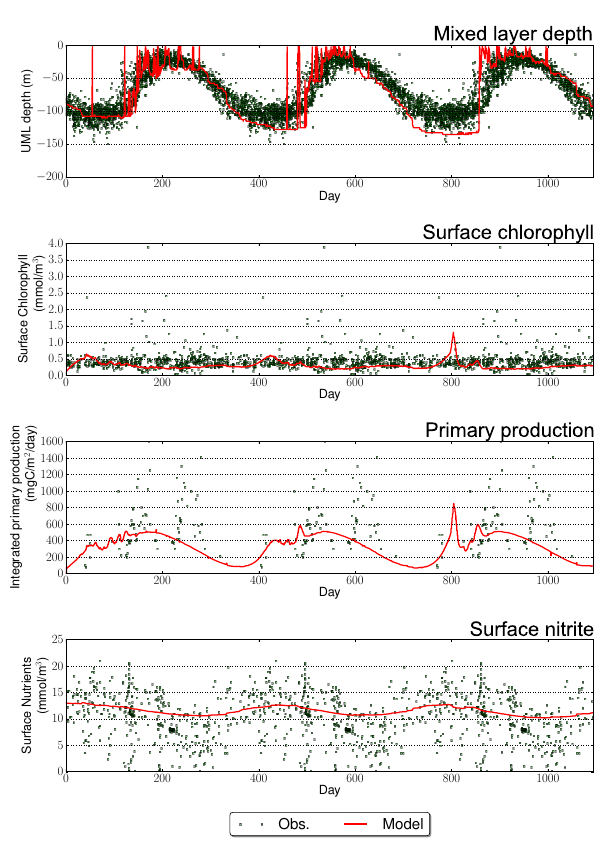
Fig. 2. Summary of simulated physical and biological behaviour at Station Papa for a uniform (2.5m), non-adaptive simulation. From top to bottom, panels show MLD, surface chlorophyll, integrated primary productivity and surface nutrients. Where available, mea- sured data are shown as green squares. Measured data are plotted against day of year due to lack of data for some